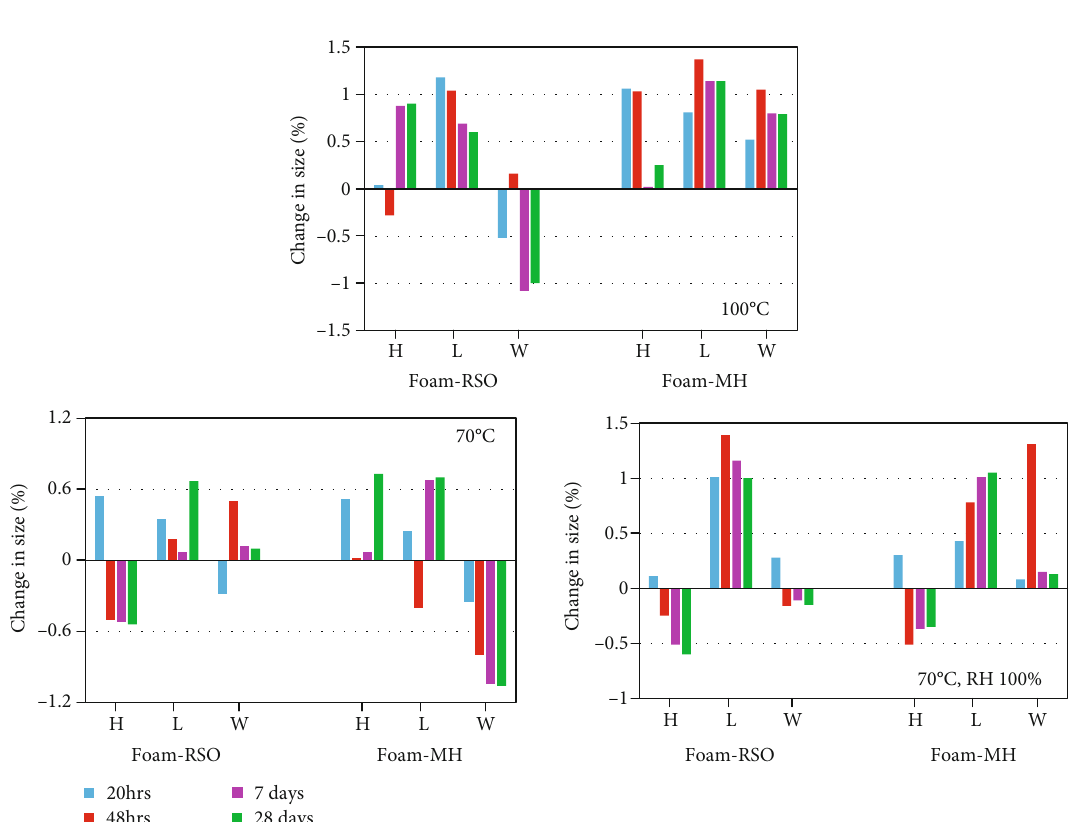
Figure 12: The change in the size of foams in environments. H: height; L: length; W: